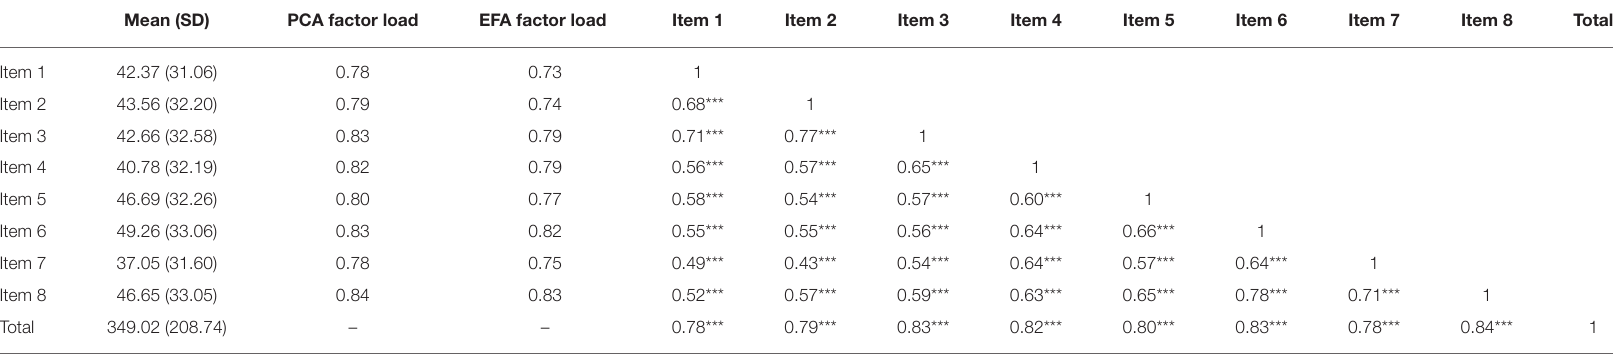
TABLE 2 | Each item factor load, common factor variance, correlation matrix of items, and total scores in Chinese version of BSRI ( n = 512).